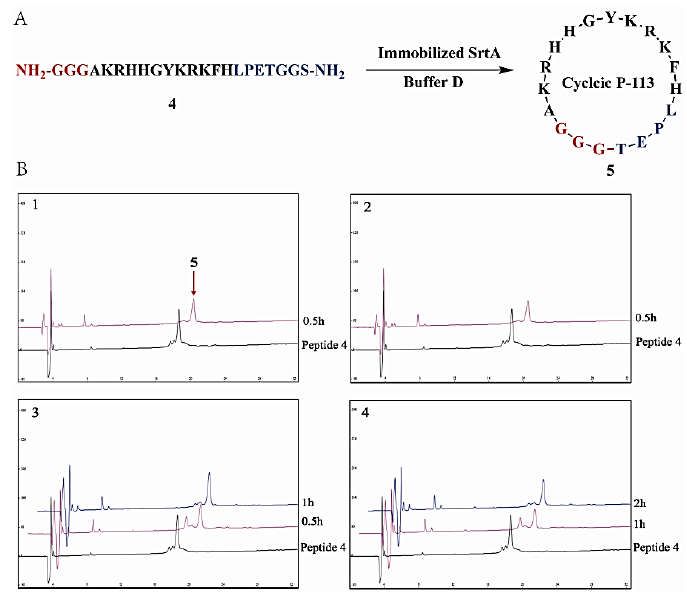
Figure 6. ( A ) Immobilized SrtA-mediated peptide cyclization of P-113; ( B ) HPLC diagraph of immobilized SrtA-mediated peptide cyclization of P-113 in different volumes; 1: 2 mL; 2: 10 mL; 3: 20 mL; 4: 40 mL. Experiments were performed in pH 7.5 at 37 °C as described in Section 3.6.2.